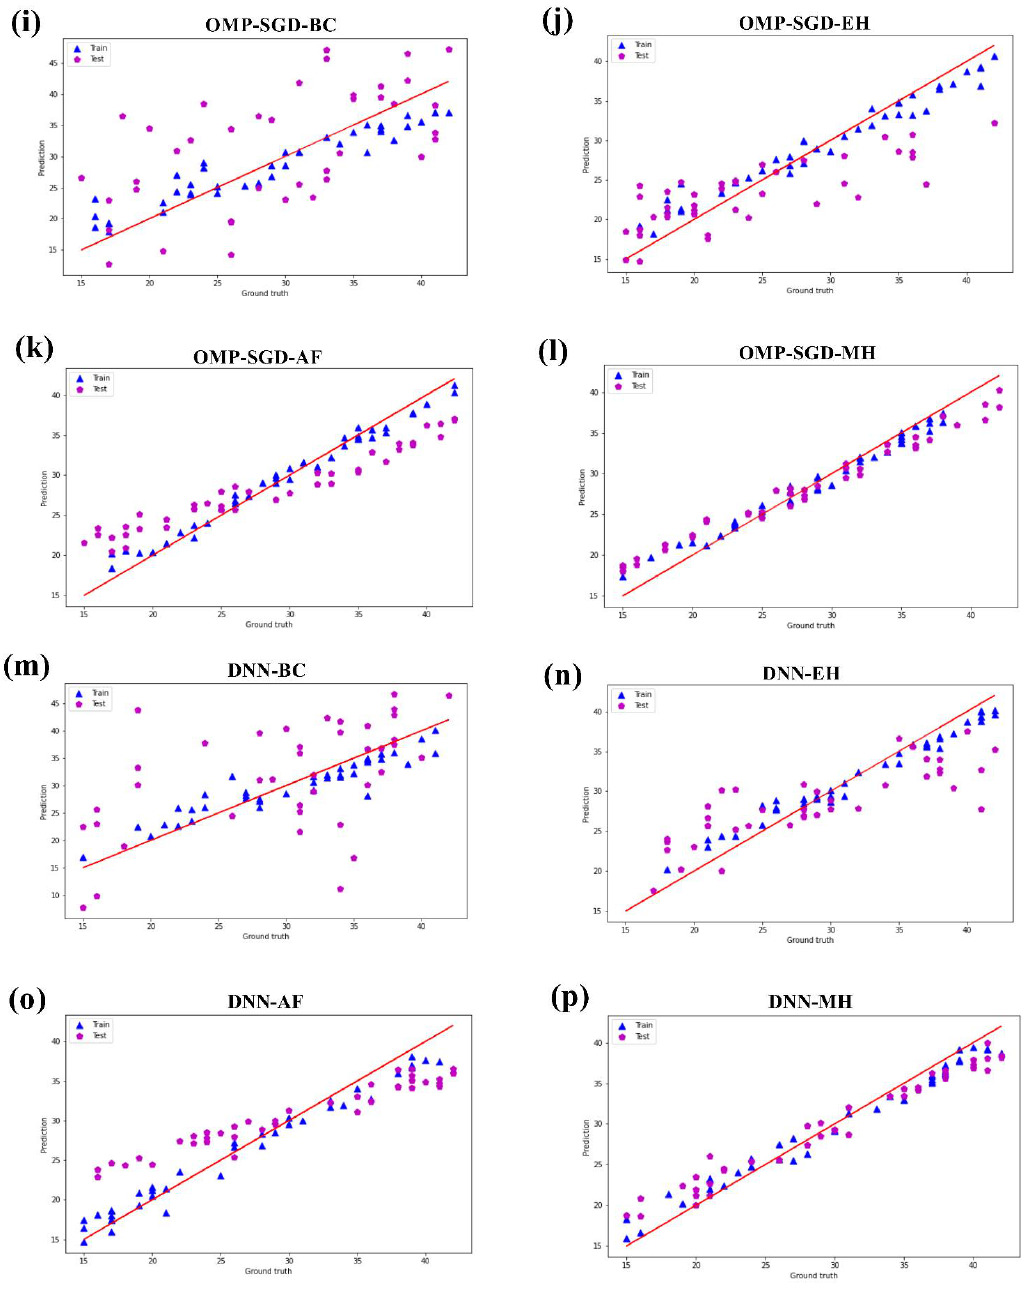
Figure 2. Training set and test set of overall preference for support vector machine ( a – d ), gradient boosted trees ( e – h ), orthogonal matching pursuit—stochastic gradient descent ( i – l ), and deep neu- ral network ( m – p ). Figure 2a,e,i,m are BC. Figure 2b,f,j,n are EH. Figure 2c,g,k,o are AF. Figure 2d,h,l,p are MH. Table 4. Using machine learning methods to classify and predict the accuracy of consumers’ overall preference and lamb shashliks preference for four various cooking